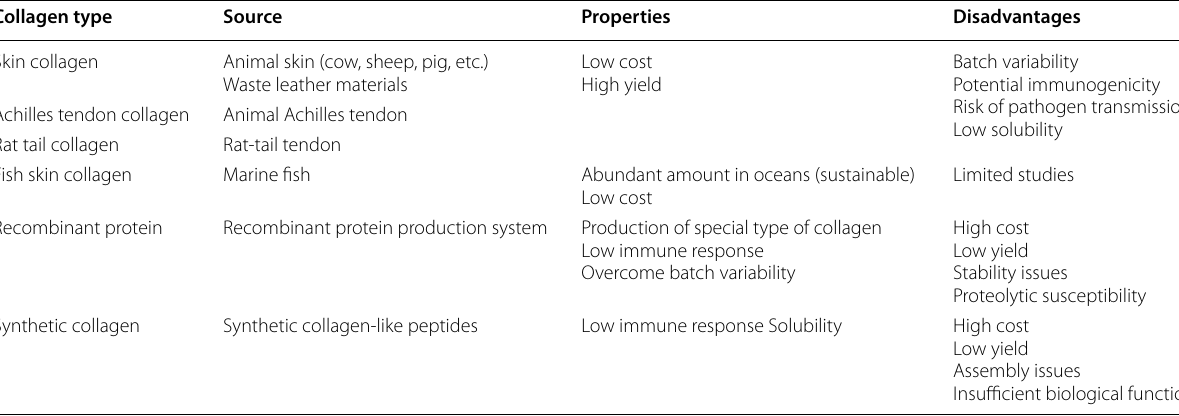
Table 1 Different sources and properties of collagen Collagen type